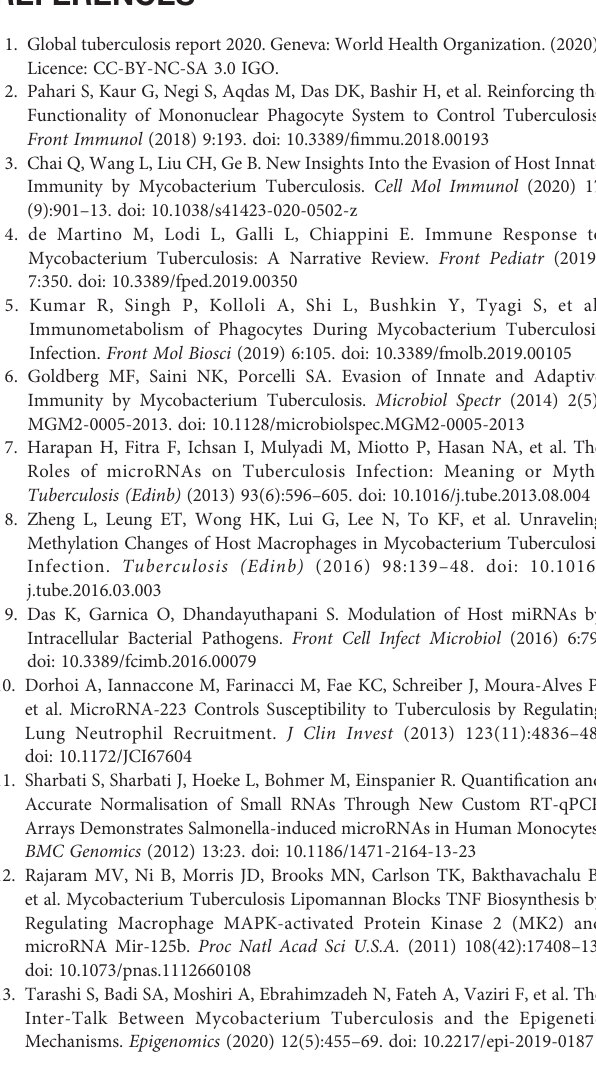
Supplementary Figure 2 | Comparison of miRNA expression between 24 and 48 hours. Volcano plot of differentially expressed miRNAs in uninfected or infected MDMs 24 and 48 hours after infection of infected conditions. n = 4 independent human donors. Red lines represent signi fi cance thresholds. Red dots represent signi fi cantly differentially expressed miRNAs. Differentially expressed miRNAs are reported with their Log2(Fold Change) (Log2(FC)) and adjusted p -values. Supplementary Table 1 | Differentially expressed miRNAs from small RNA sequencing. See attached Supplemental_Table_1_DEmiRs.csv fi le . Supplementary Table 2 | Differentially expressed mRNAs from total RNA sequencing. See attached Supplemental_Table_2_DEmiRs.csv fi le fi le.